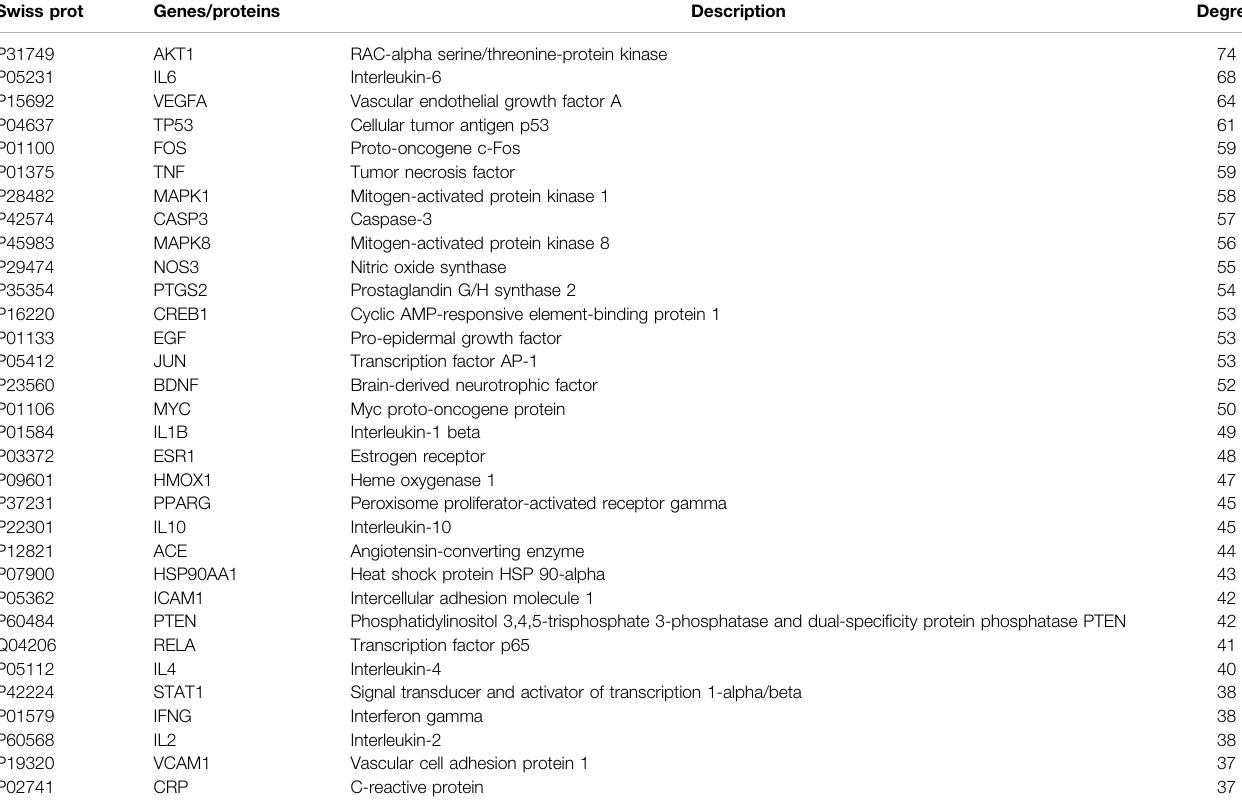
TABLE 2 | The topological parameters of 32 major targets. Swiss prot